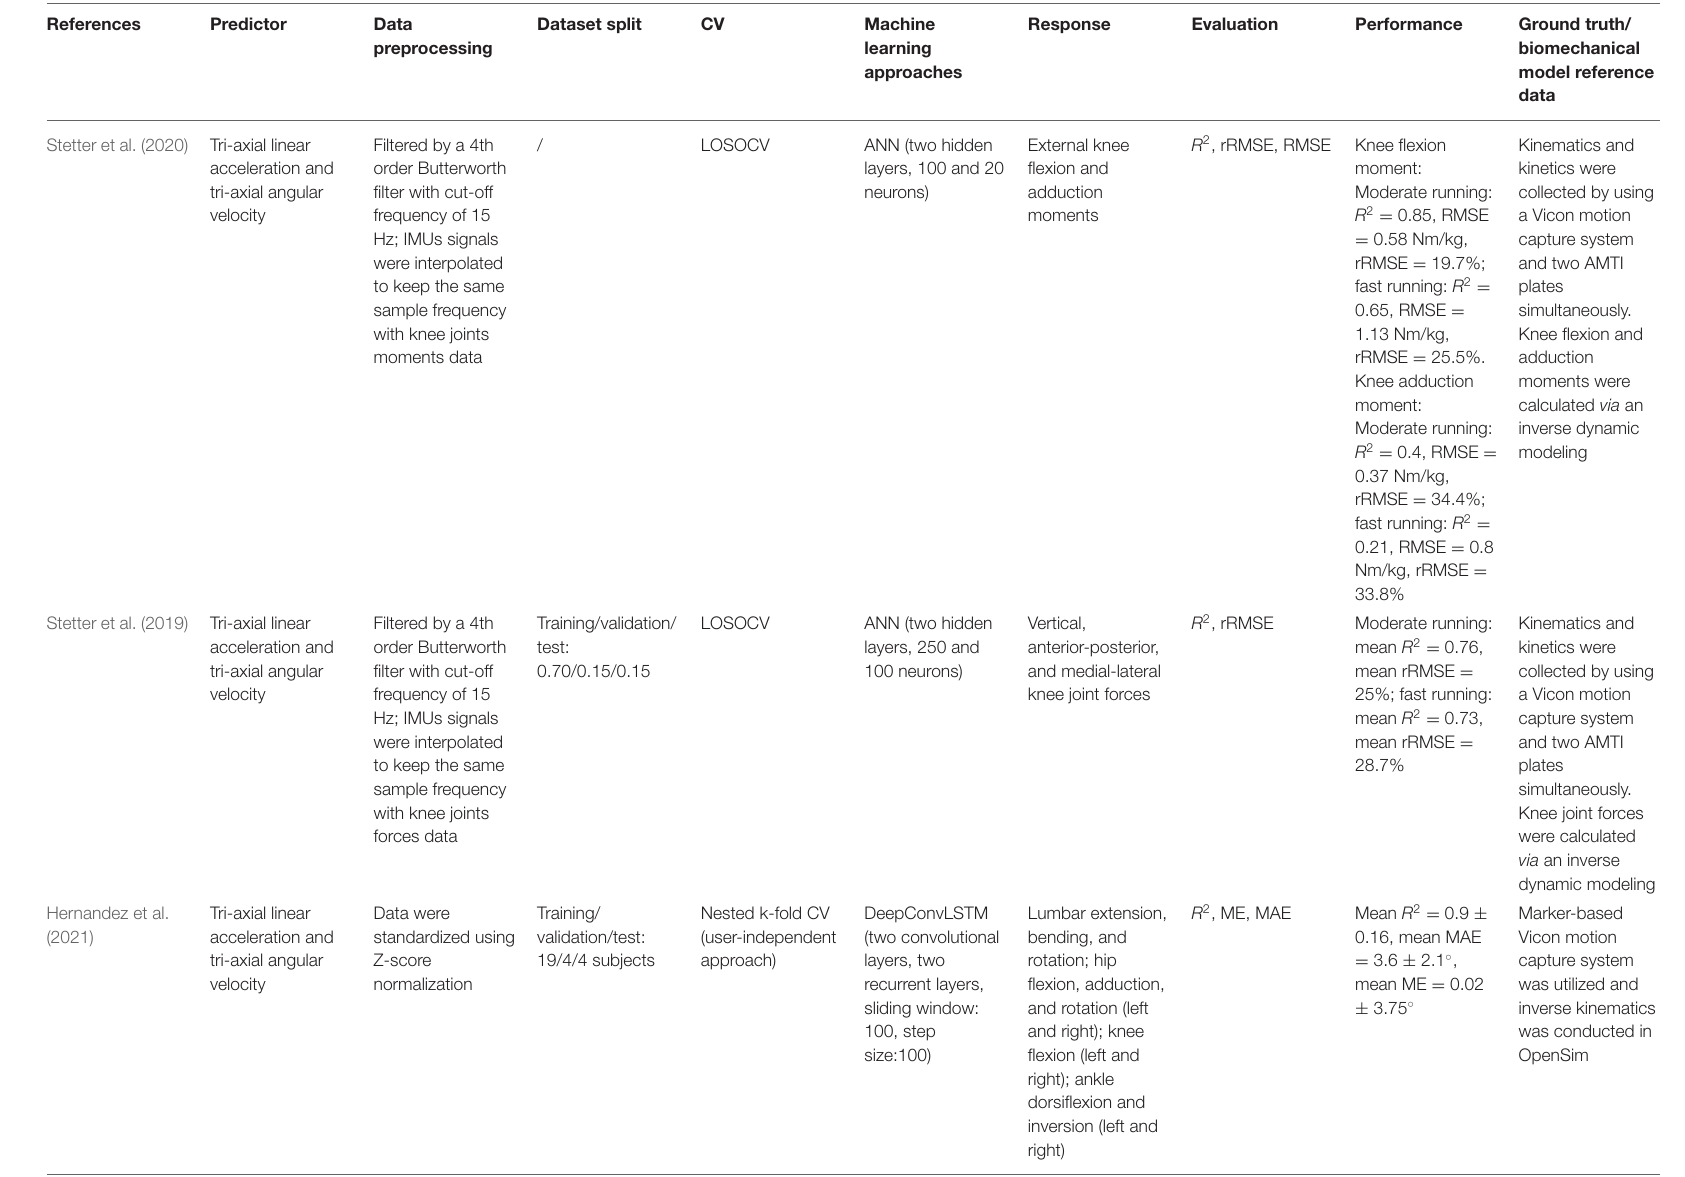
TABLE 4 | The detailed machine learning